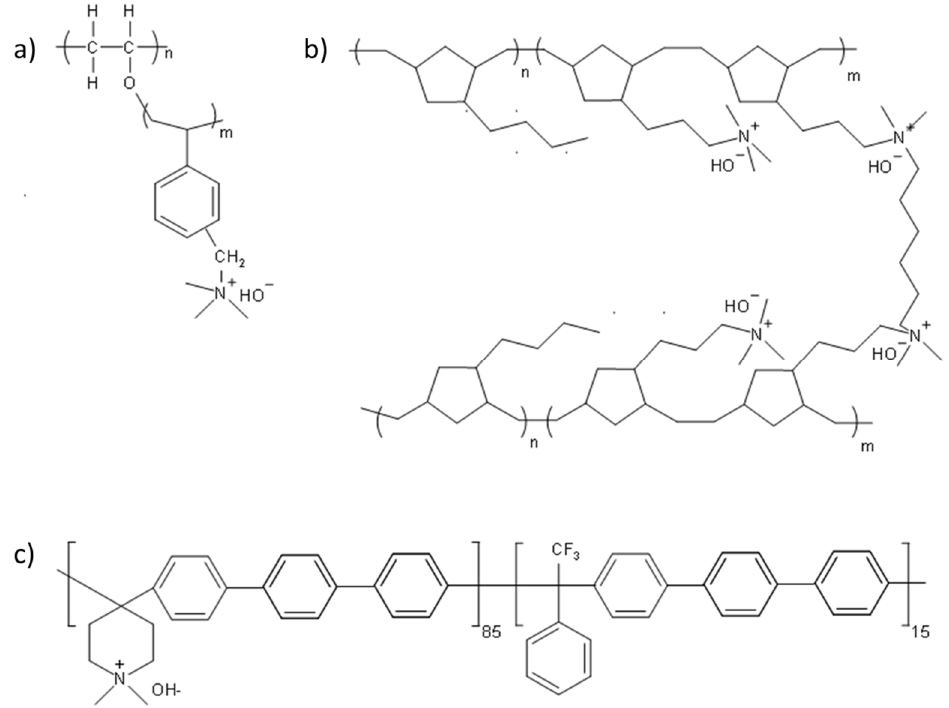
Figure 1. The structure of anion exchange membranes (AEMs) used in this study ( a ) high-density polyethylene polymer with a benzyltrimethylammonium cation (HDPE-BTMA) and low-density polyethylene polymer with a benzyltrimethylammonium cation (LDPE-BTMA), ( b ) poly (norbornene) copolymer of GT64-15, GT72-5 and GT78-15 and ( c ) poly(aryl piperidinium)-based polymer with a terphenyl chain (PAP-TP-85) [1,3,4,29,40–43]. Table 1. Key properties of the polyethylene-based, poly(norbornene)-based and poly(aryl piperidinium)-based AEMs used in this study.